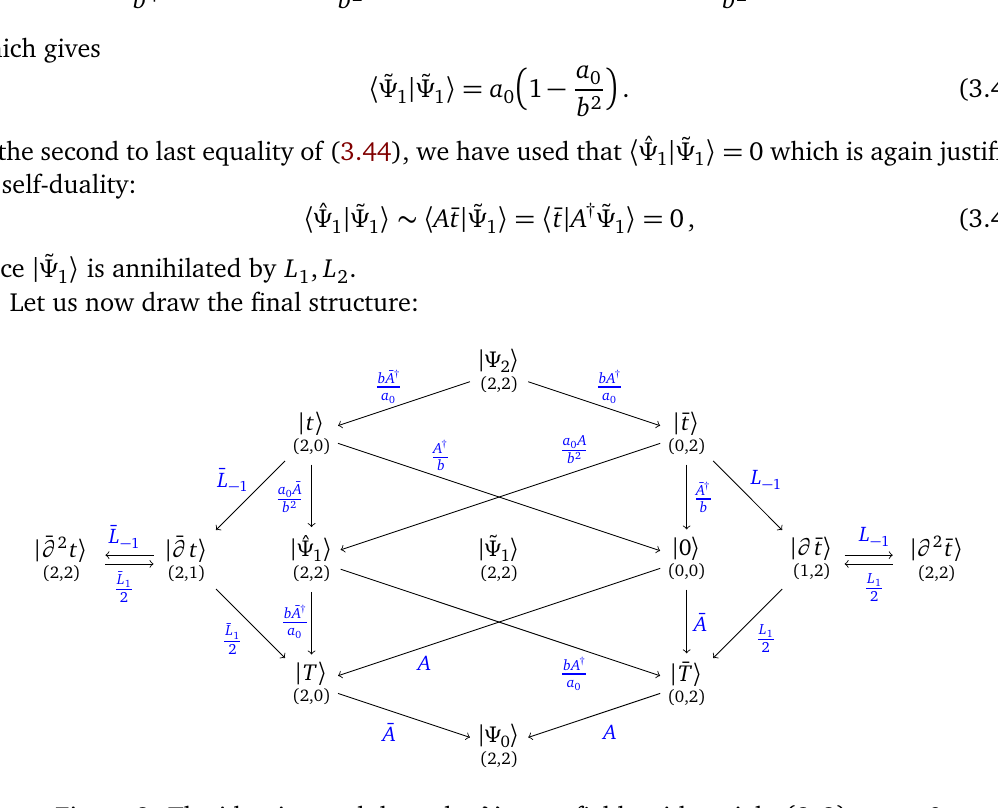
Figure 2: The identity module under V up to fields with weight ( 2,2 ) at c =